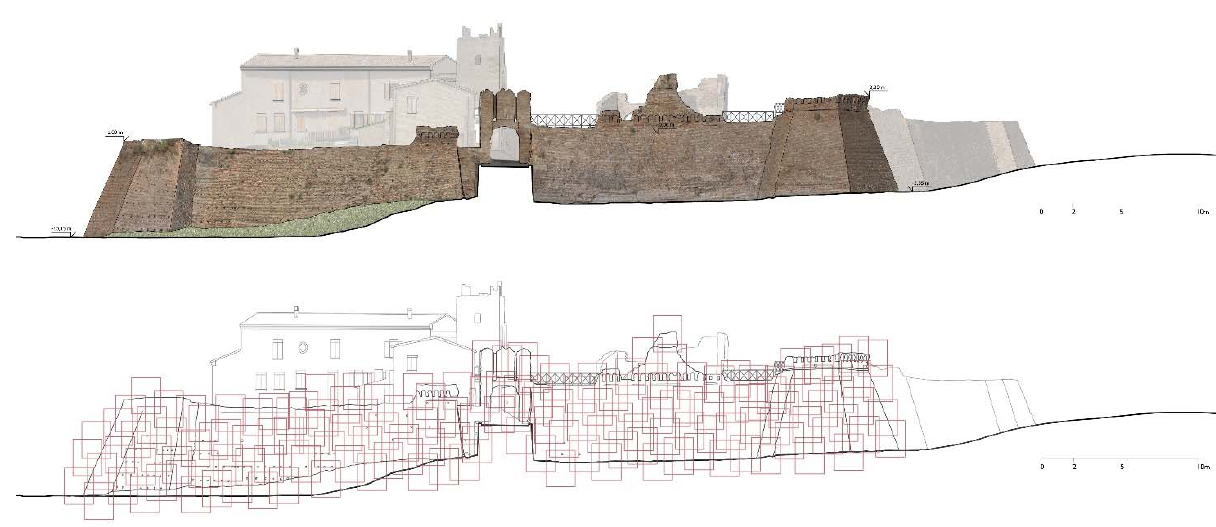
Figure 6. Coriano, photogrammetry of side S (surveyors F. Galli, C. Magnani, D.